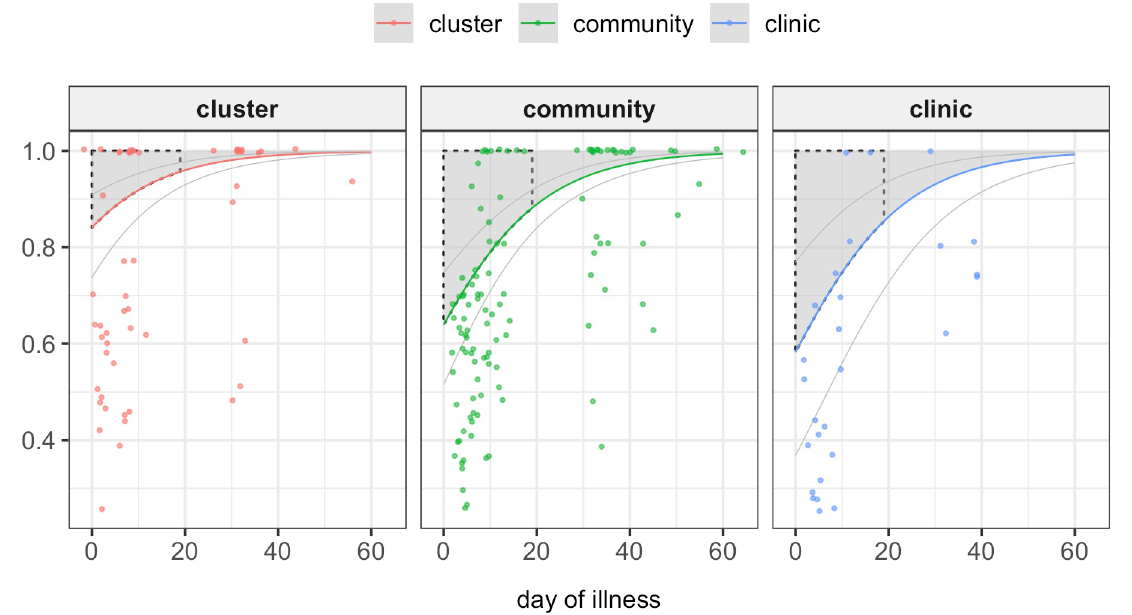
Fig 3. HRQoL by day of illness and recruitment modality Multiple regression analysis predicted HRQoL scores (y-axis) by day of illness (x-axis) and recruitment modality (individual panels). Individual points represent actual measured HRQoL scores. Thick colored lines represent model predicted scores and faint lines represent +/-2 x standard error. As the model included age as a continuous variable, we graphed predicted scores for the median age of 16 years and as the differences in sexes was negligible and non-significant, we only represent males. Shaded areas represent predicted healthy life lost due to a dengue episode. Black dashed lines enclose the proportion of healthy life lost within the first 20 days of illness.